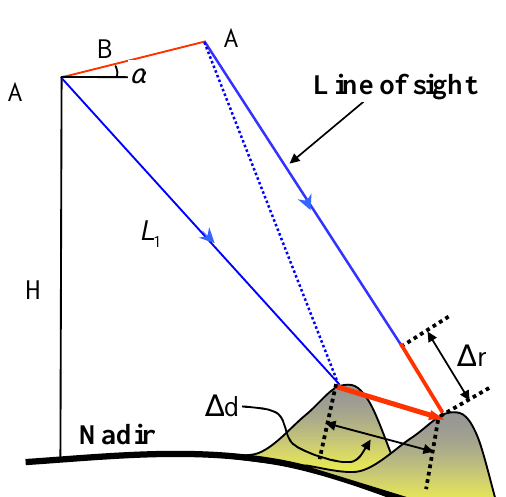
Figure 2. Geomtry of